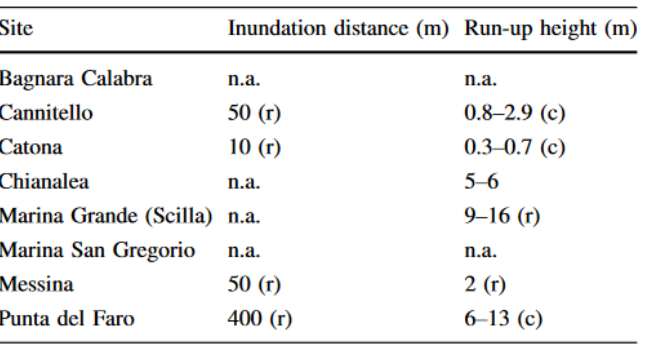
Figure 3. ( a ) Topo-bathymetry of the region where the slide occurred. ( b ) Satellite image from Google Earth of Scilla, with Marina Grande and Chianalea (Zaniboni et al, 2016).